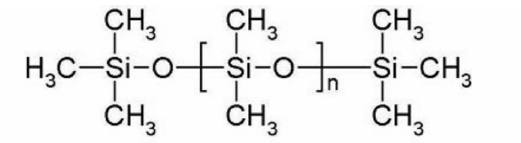
Figure 9. Structure of a linear silicone polymer